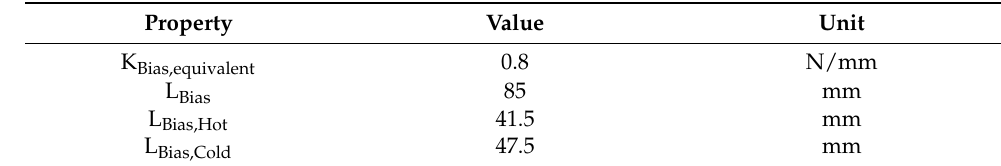
Table 6. Mechanical and geometrical values assumed for the design of the bias spring.